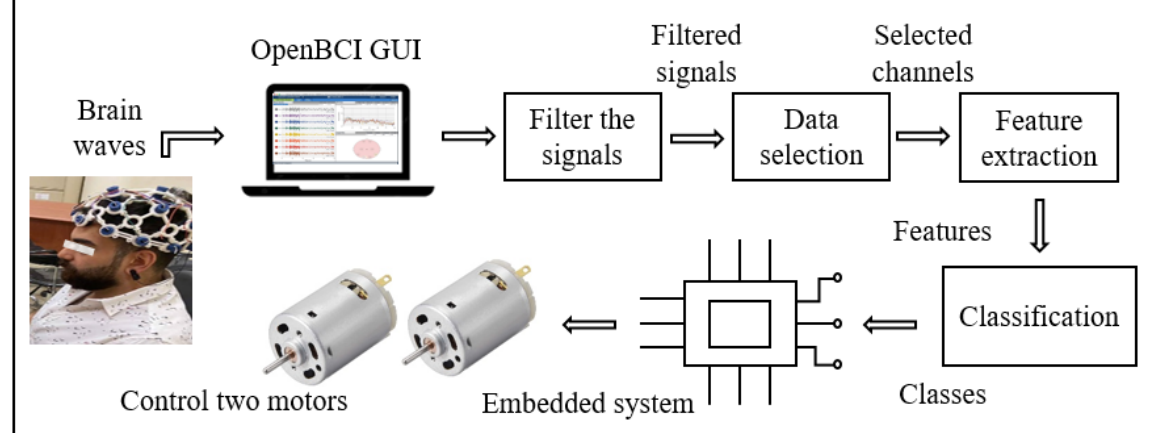
Fig. 9. The block